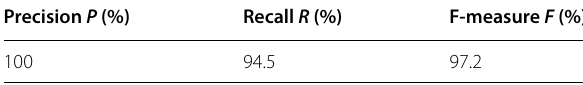
Table 8 Result of the on-line experiment Precision P